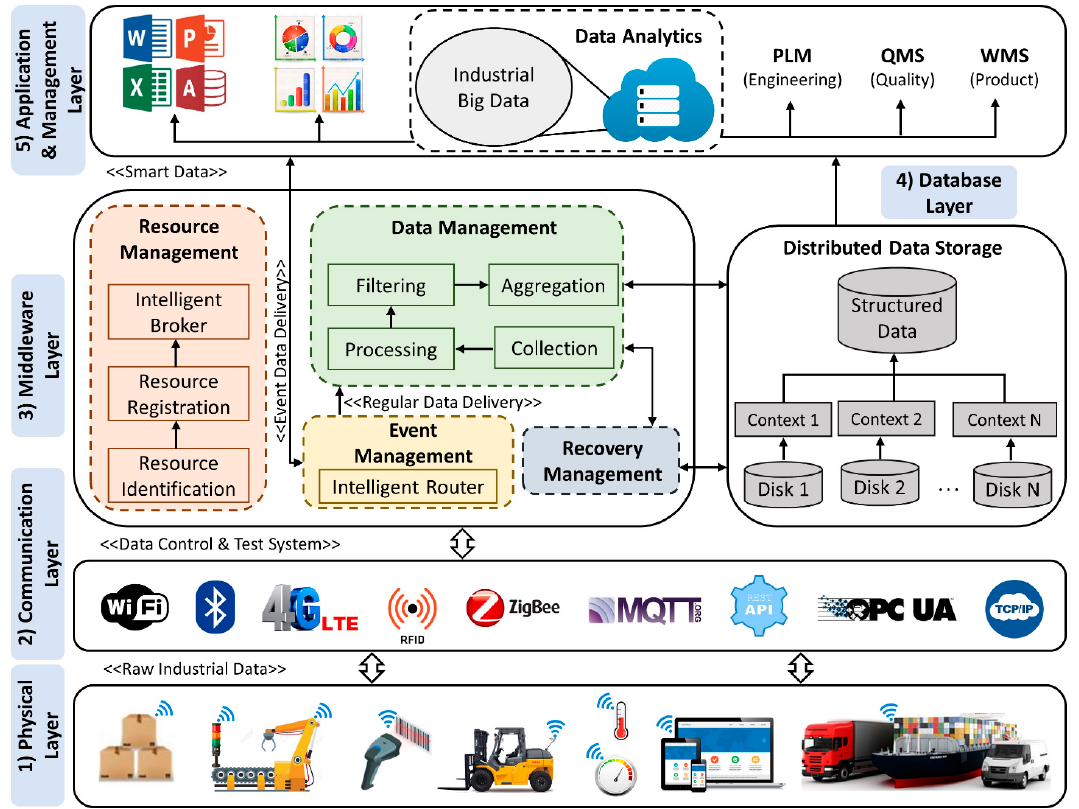
Figure 3. A framework of an IoT-based industrial data management system. Note: PLM indicates Product Lifecycle Management, QMS Quality Management System, WMS Warehouse Management System.